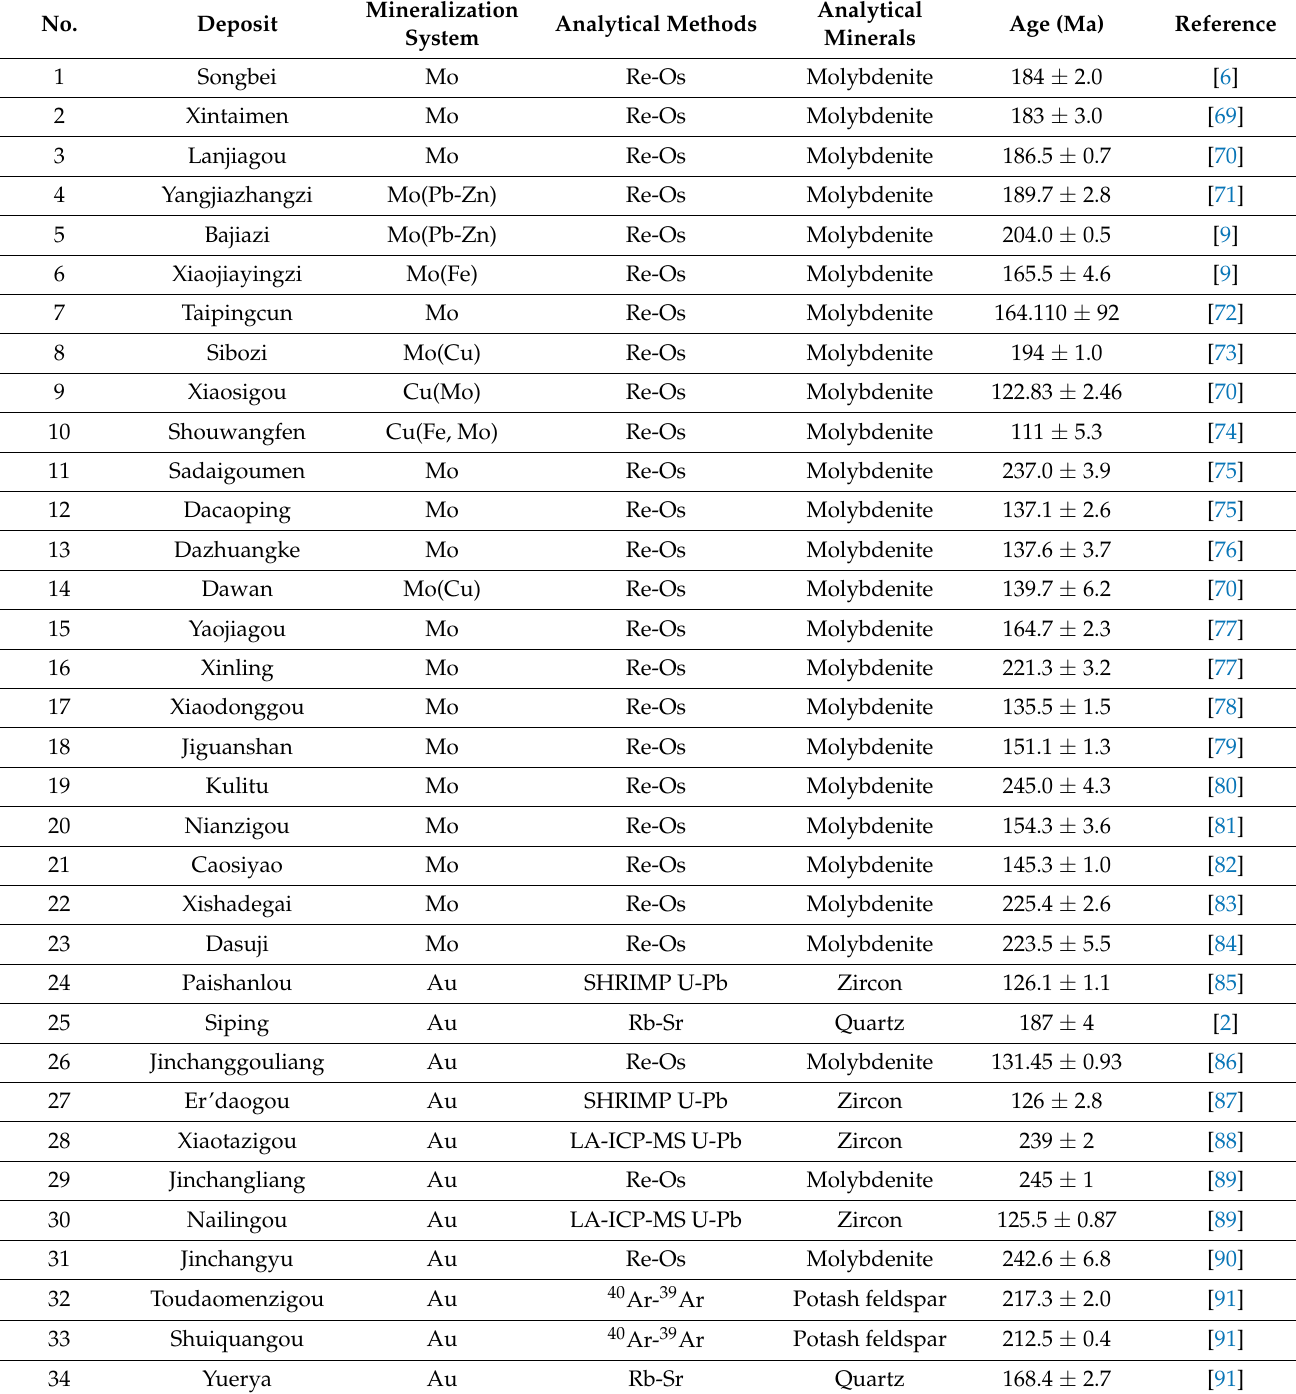
Table 4. Ages of ore deposits in the northern flank of the